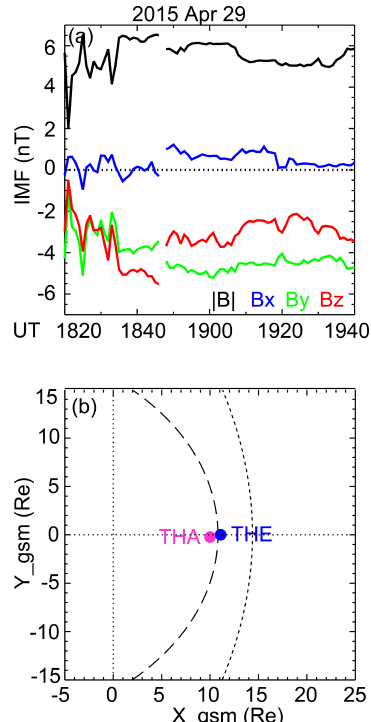
Figure 6. OMNI IMF condition and THEMIS satellite locations on 29 April 2015 in a similar format to Fig.